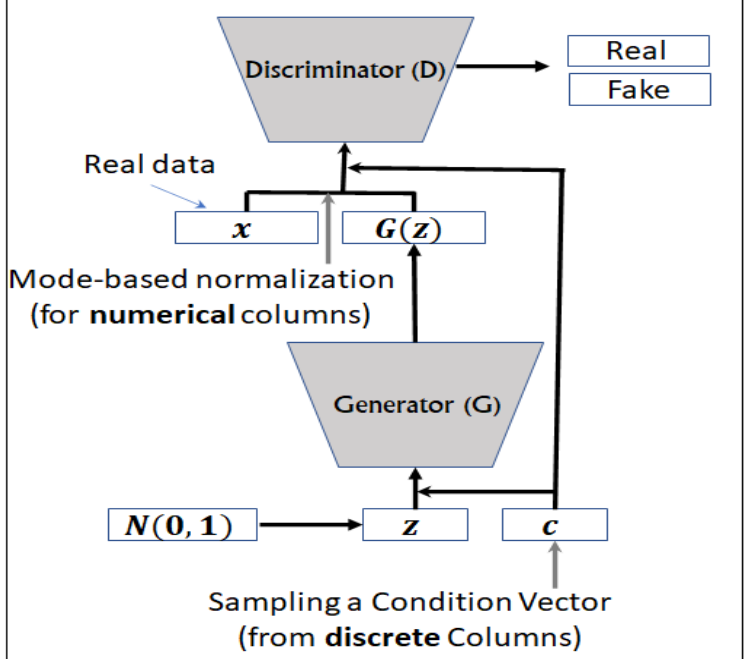
Figure 16. Overview of SD generation with generative adversarial networks